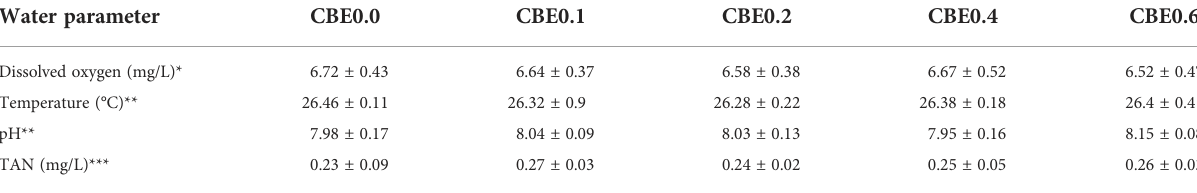
TABLE 2 Water parameters under experimental conditions. Water